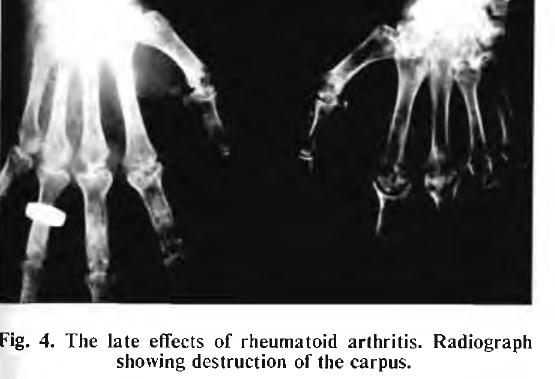
Fig. 5. Synovitis and swelling of the M .C.P.